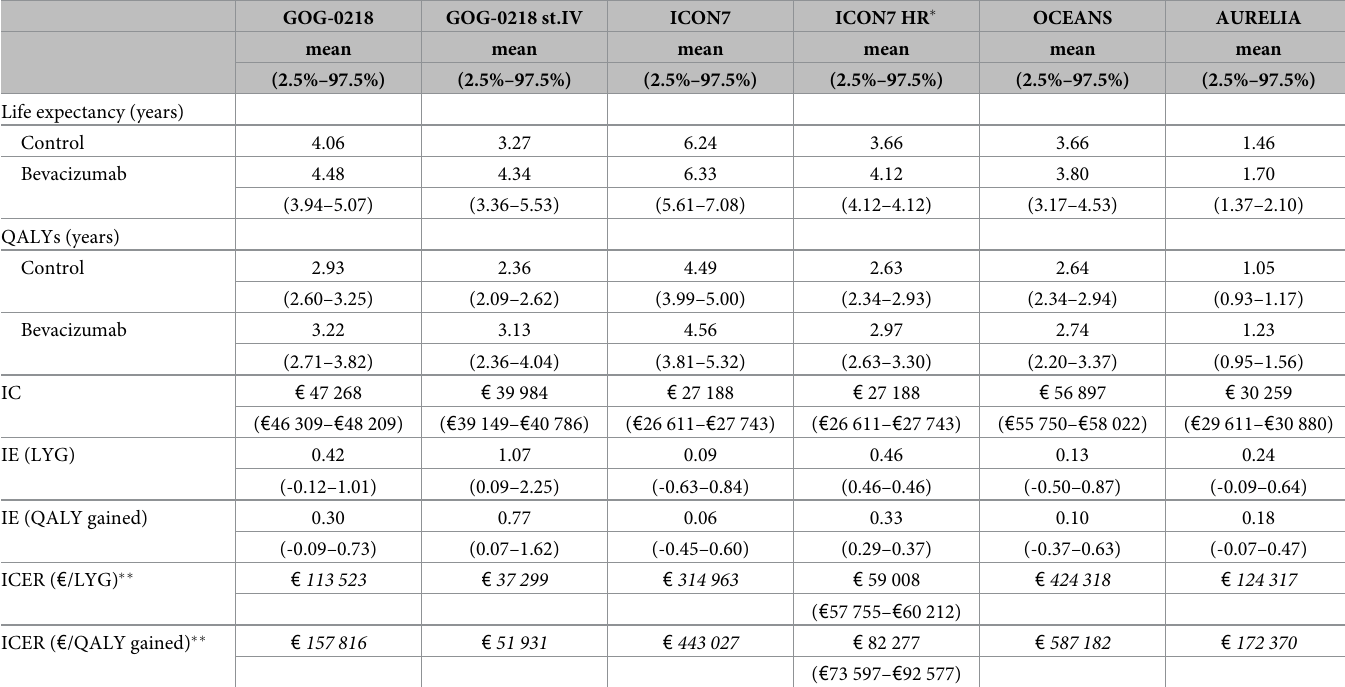
Table 5. IC, IE & ICERs for the base case scenario (GOG-0218 (st.IV), ICON7 (high risk), OCEANS, and